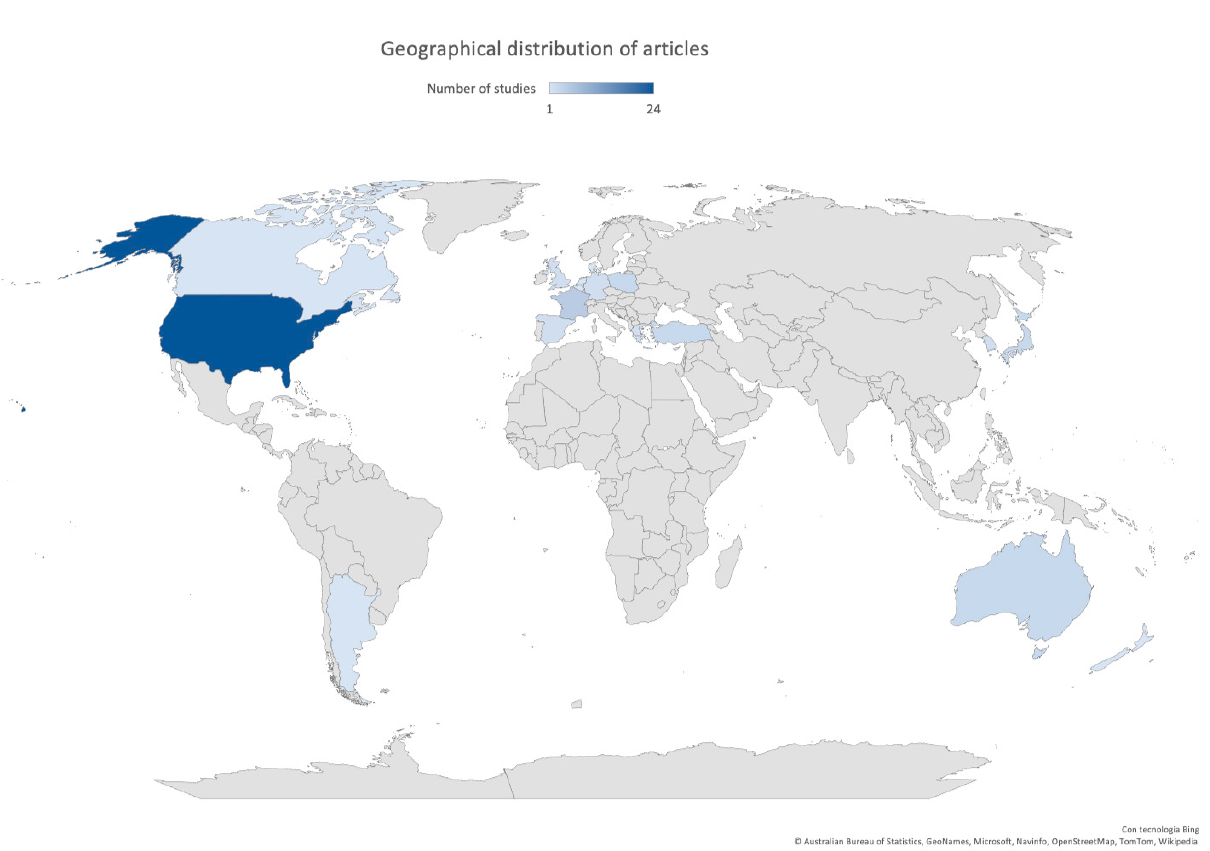
Figure 2. Geographical distribution of articles included in this